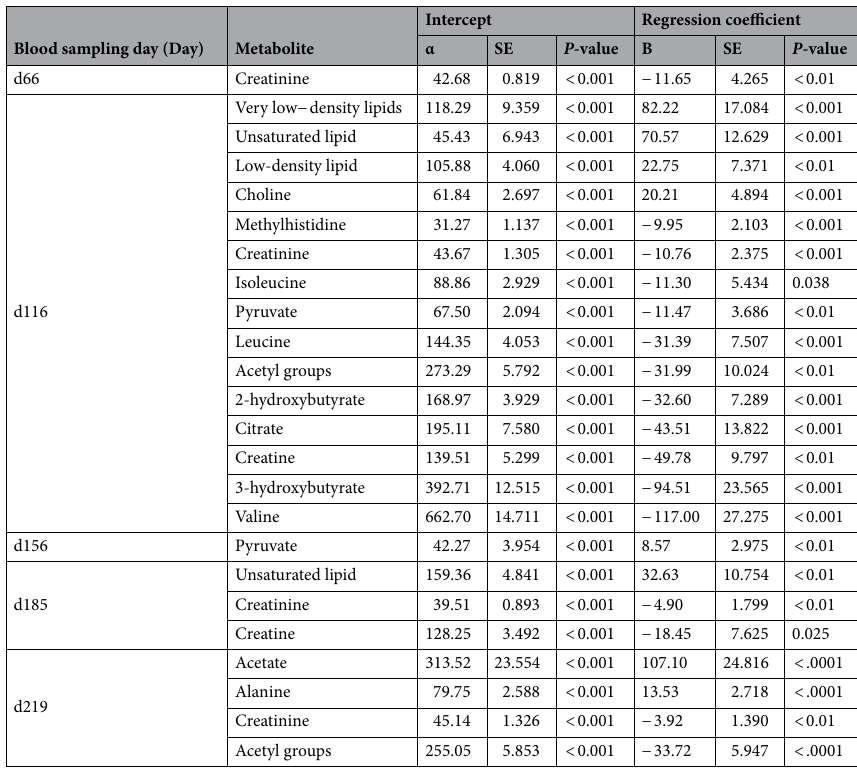
Table 2. Regression coefficient (β), intercept (α) and P -value for the intercept and regression coefficient between the relative abundance of blood metabolites and live weight change (LWC) on each of five points (Day). Only metabolites with a Day x LWC interaction are shown ( P <